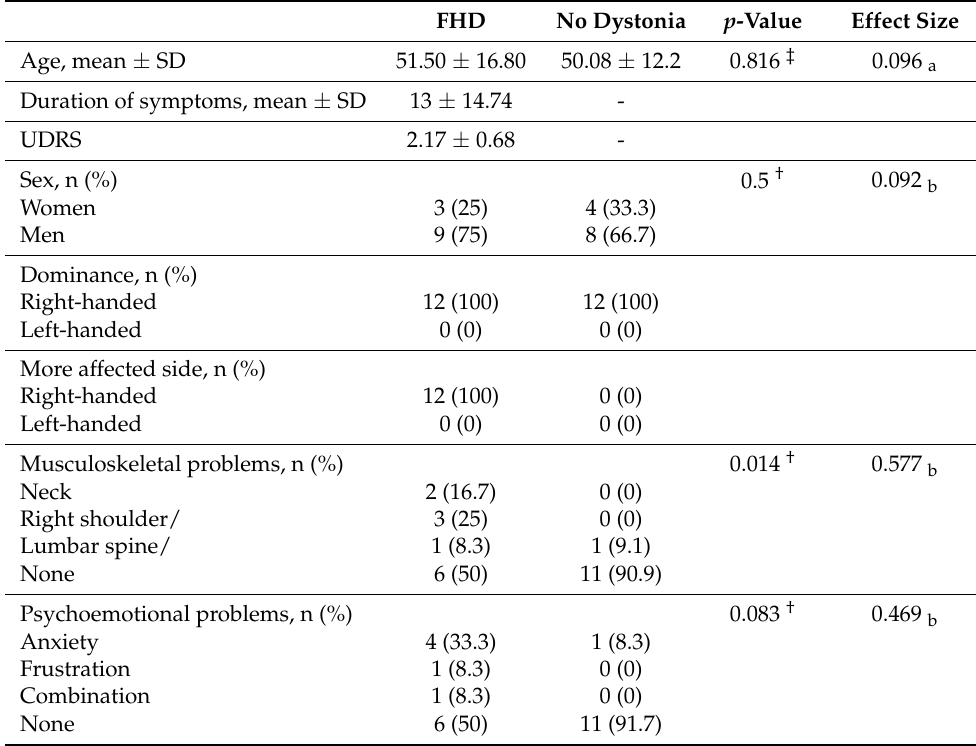
Table 1. Characteristics of the sample, focal hand dystonia (n = 12) and no dystonia (n = 12). FHD No Dystonia p